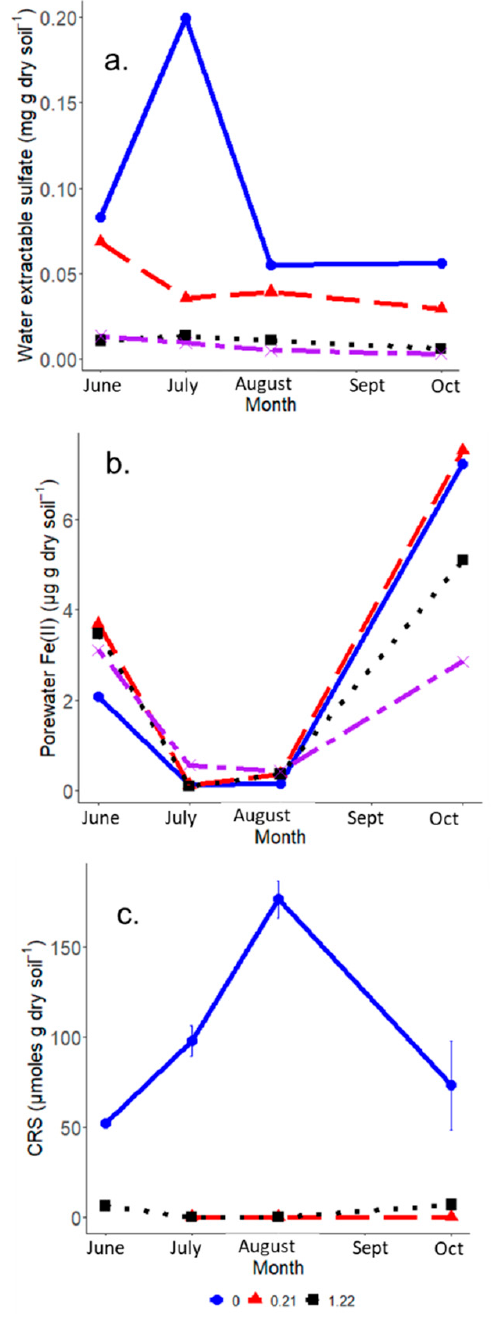
Figure 4. ( a ) Water extractable SO 42 − (mg g dry soil − 1 ), ( b ) Fe(II) ( µ g Fe(II) g dry soil − 1 ), and ( c ) chromium reducible sulfur (CRS, µ moles g dry soil − 1 ) versus distance from the downstream site (km) and through time (month). Error bars denote standard errors.